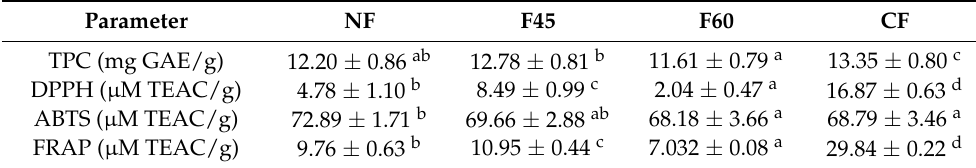
Table 6. Total Phenolic content and antioxidant activity of Maya nut flours. Parameter NF F45 F60